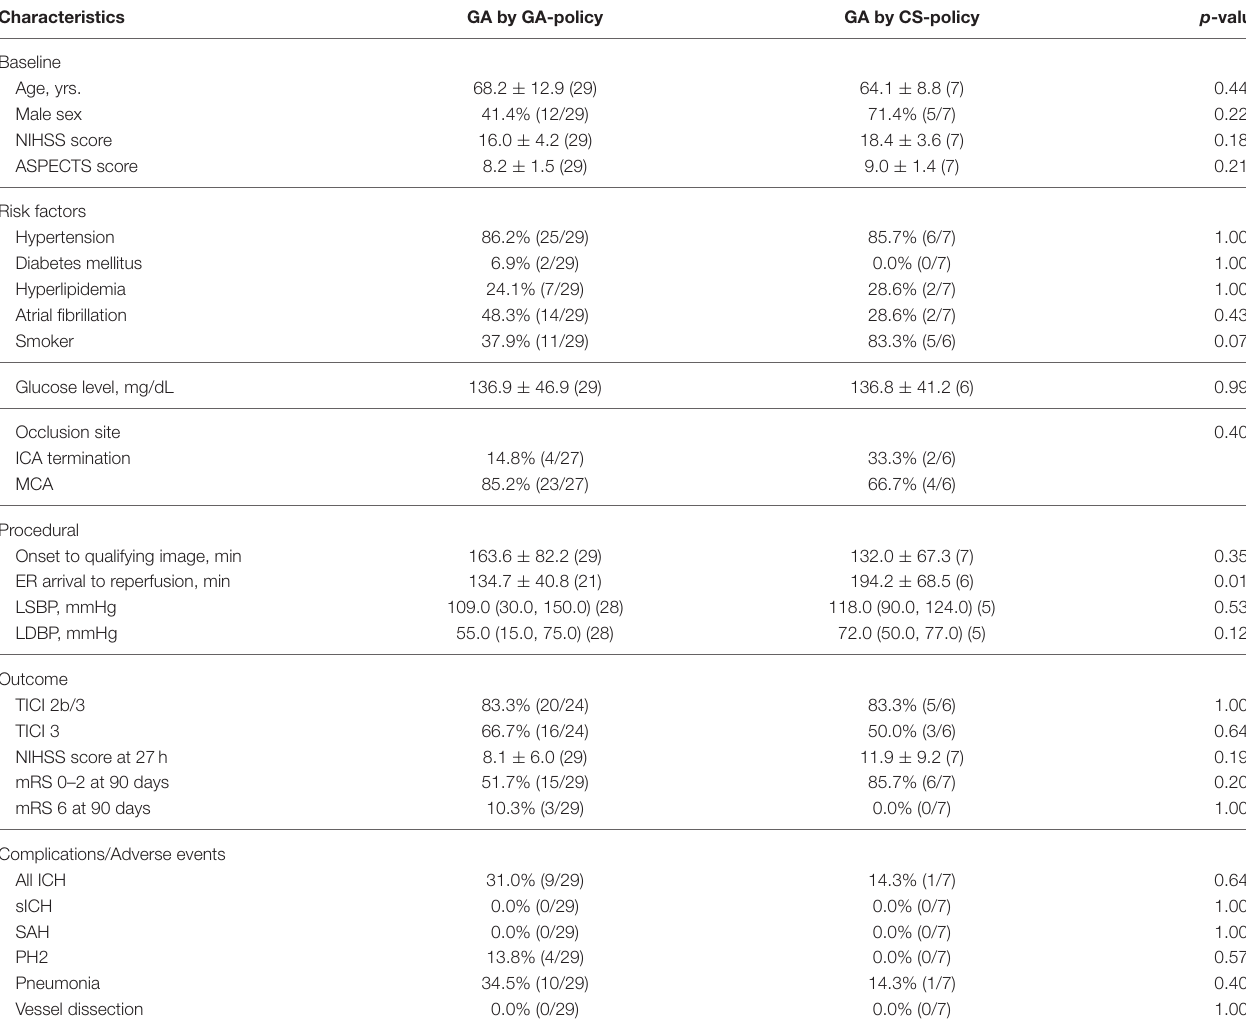
TABLE 4 | Baseline, procedural, safety and outcome data for the GA by GA-policy group and GA by CS-policy group. Characteristics GA by